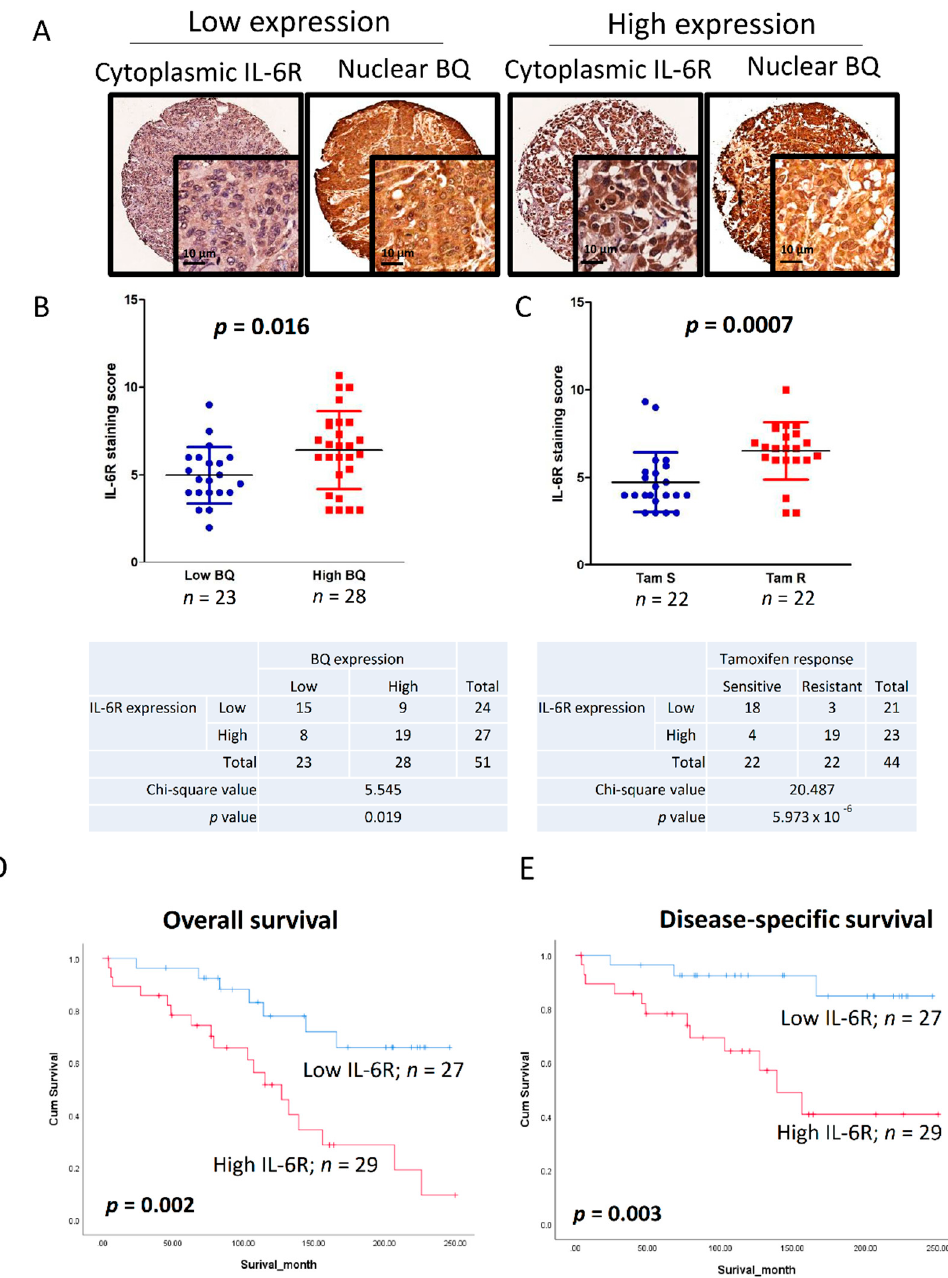
Figure 6. Clinical significance of IL-6R in ER+ breast cancer. ( A ) IHC showing representative high and low expressions of cytoplasmic IL-6R and nuclear BQ respectively. ( B ) Expression of IL-6R was compared with low nuclear BQ and high nuclear BQ expression groups. Mann–Whitney U test was employed to determine the statistical significance between two groups. Chi-square text was used to determine the correlation between the expression of IL-6R and BQ. ( C ) Expression of IL-6R was significantly high ( p = 0.005; Mann–Whitney U test; p = 1.9 × 10 − 5 ; Chi-square test). Kaplan–Meier analysis showing ( D ) overall survival ( p = 0.002; log-rank test) and ( E ) disease-specific survival ( p = 0.003; log-rank test). Patients with high expression of IL-6R ( n = 29) have a poorer survival outcome compared with patients with low IL-6R expression ( n = 27). Table 3 Cox regression analyses of overall survival in ER+ breast cancer patients.